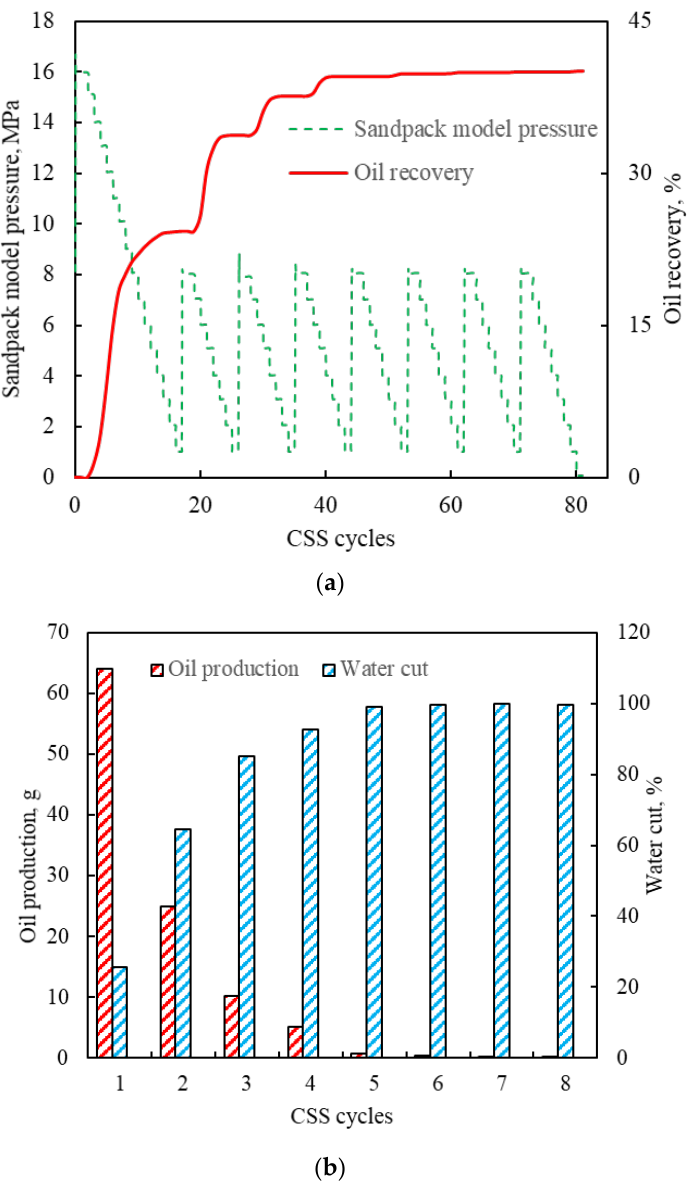
Figure 4. Results of the one-dimensional CSS experiment: ( a ) oil recovery and pressure; ( b ) oil production and water cut.